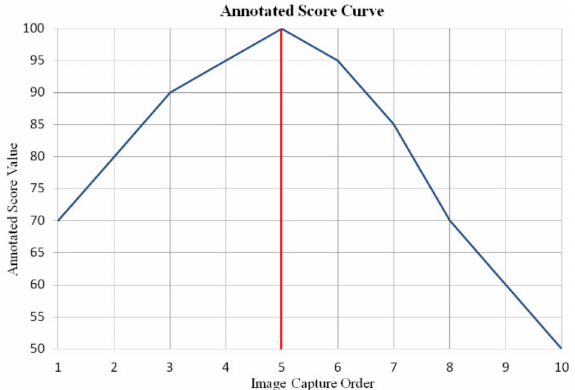
Figure 6. Annotated score curve of the image group displayed in Figure 5a. The abscissa is the image capture order in the autofocus process, and the 5th image is the clearest image. The ordinate is the annotated score